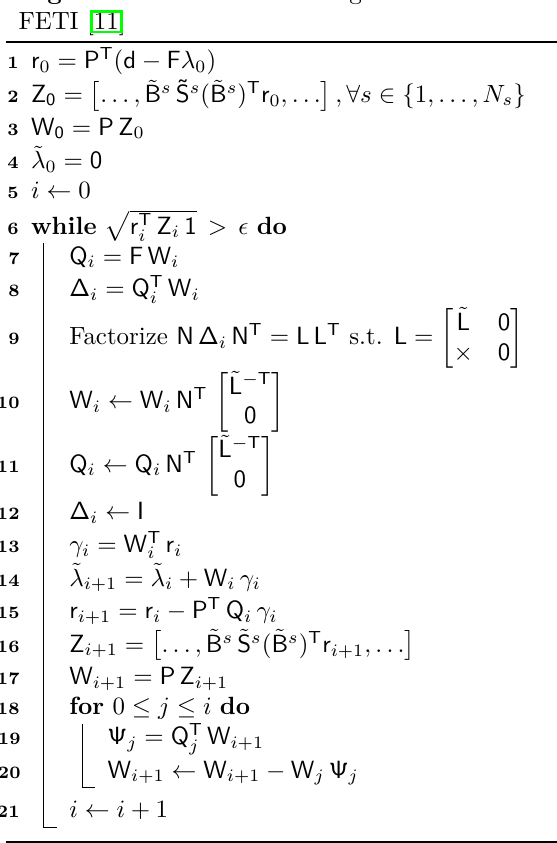
Algorithm 1: Rank-Revealing